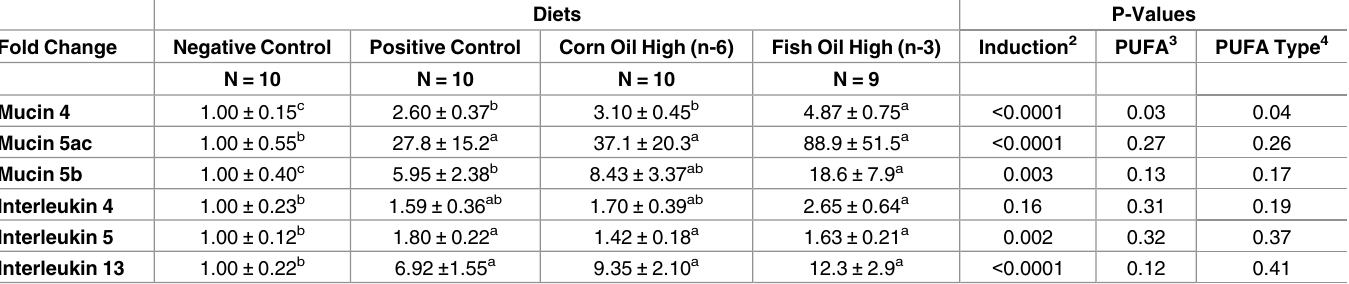
Table 7. Fold changes in selected lung tissue mRNAs specific for mucin (Muc4, Muc5ac, and Muc5b) and Th2 cytokine (IL-4, IL-5, and Il-13) genes, after mice were fed (n-3) or (n-6) PUFA enriched foods for 8 weeks and then sensitized and challenged with OVA for an additional 4 weeks compared with mice fed control food that were sensitized and challenged with saline (Negative Control) or OVA (Positive Control) 1